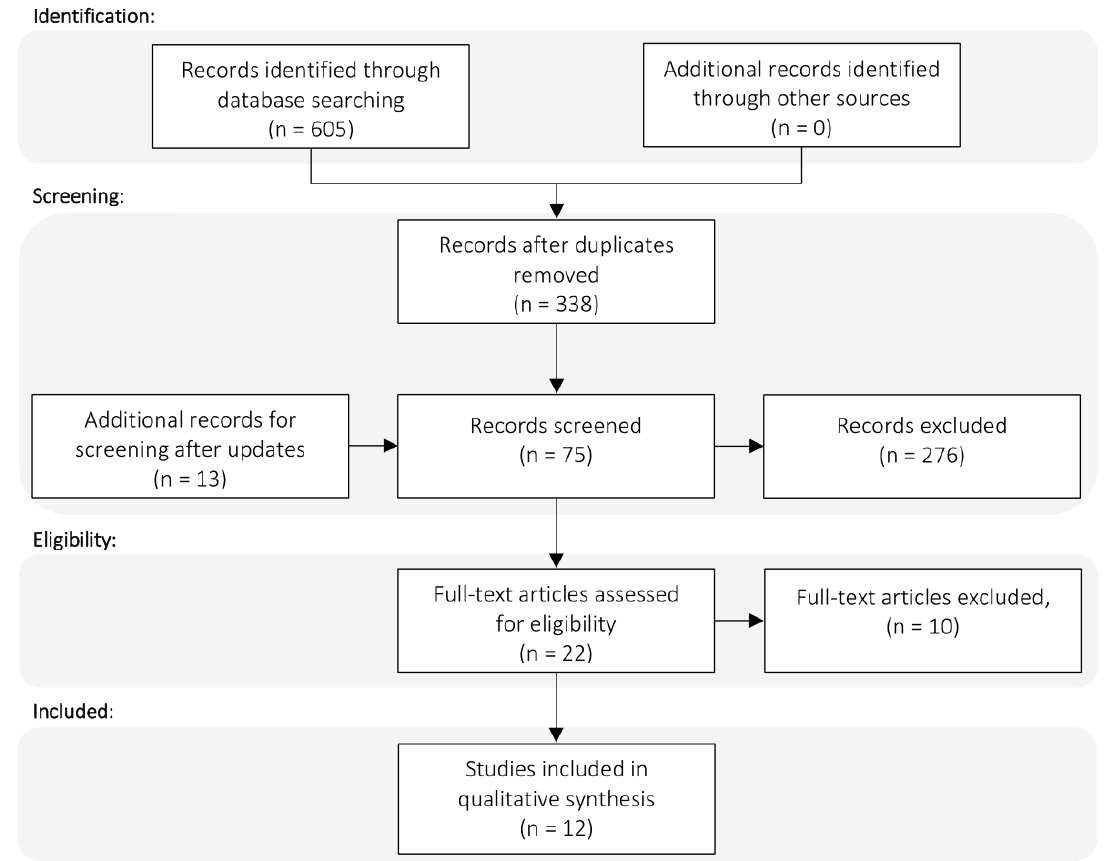
Figure 1: Flow chart for the process of study